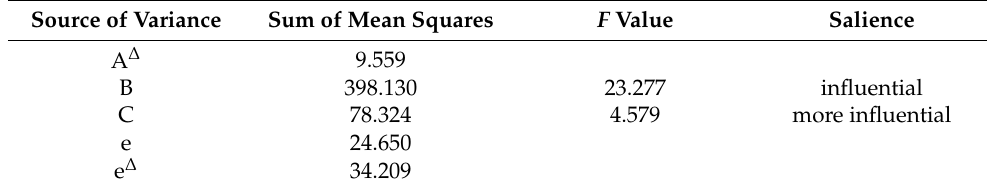
Table 8. Orthogonal test variance analysis.